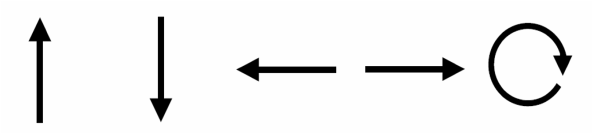
Figure 7. The background gesture classes considered in the testing set.